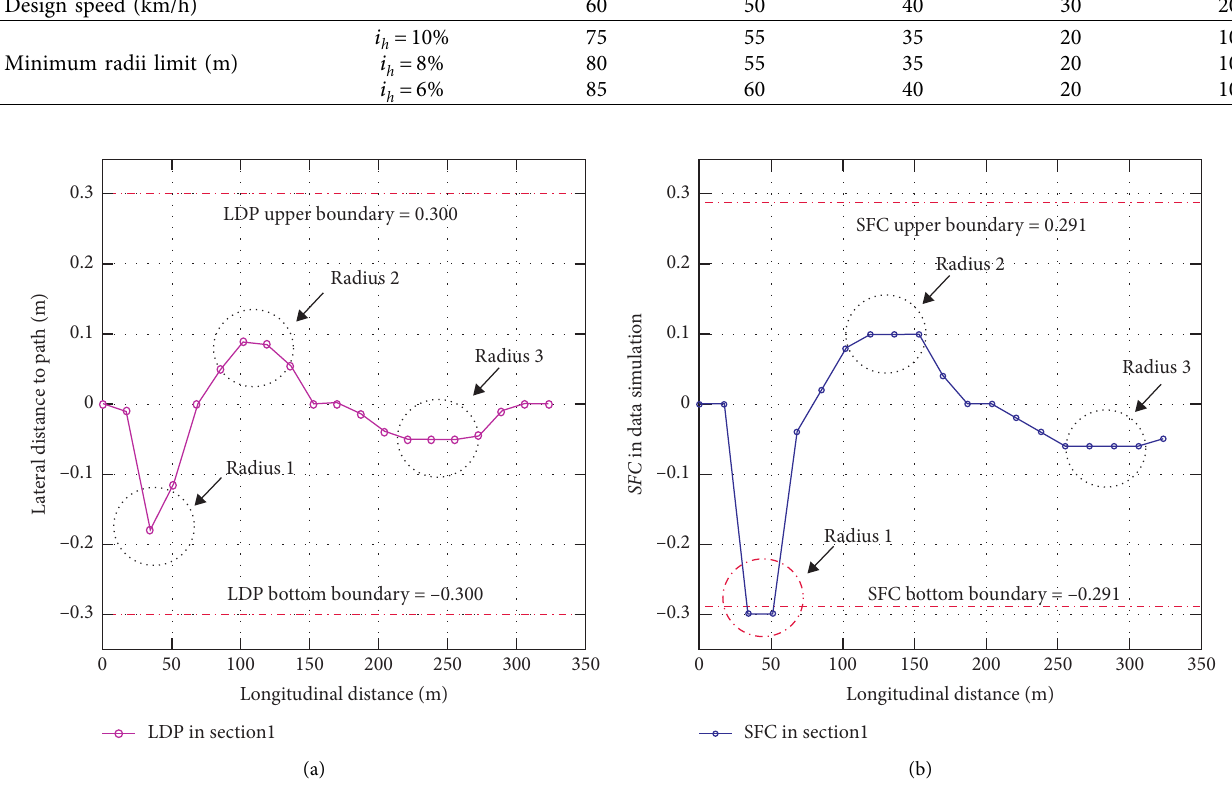
Figure 8: The simulation results of Section 1. (a) Lateral Distance Path Change Trend. (b) SFC Change Trend.